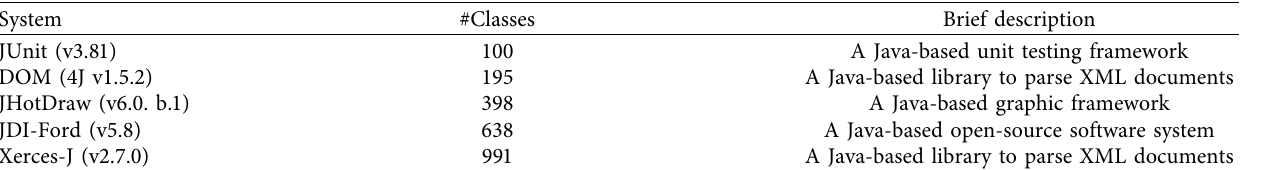
Table 1: Java-based software projects.